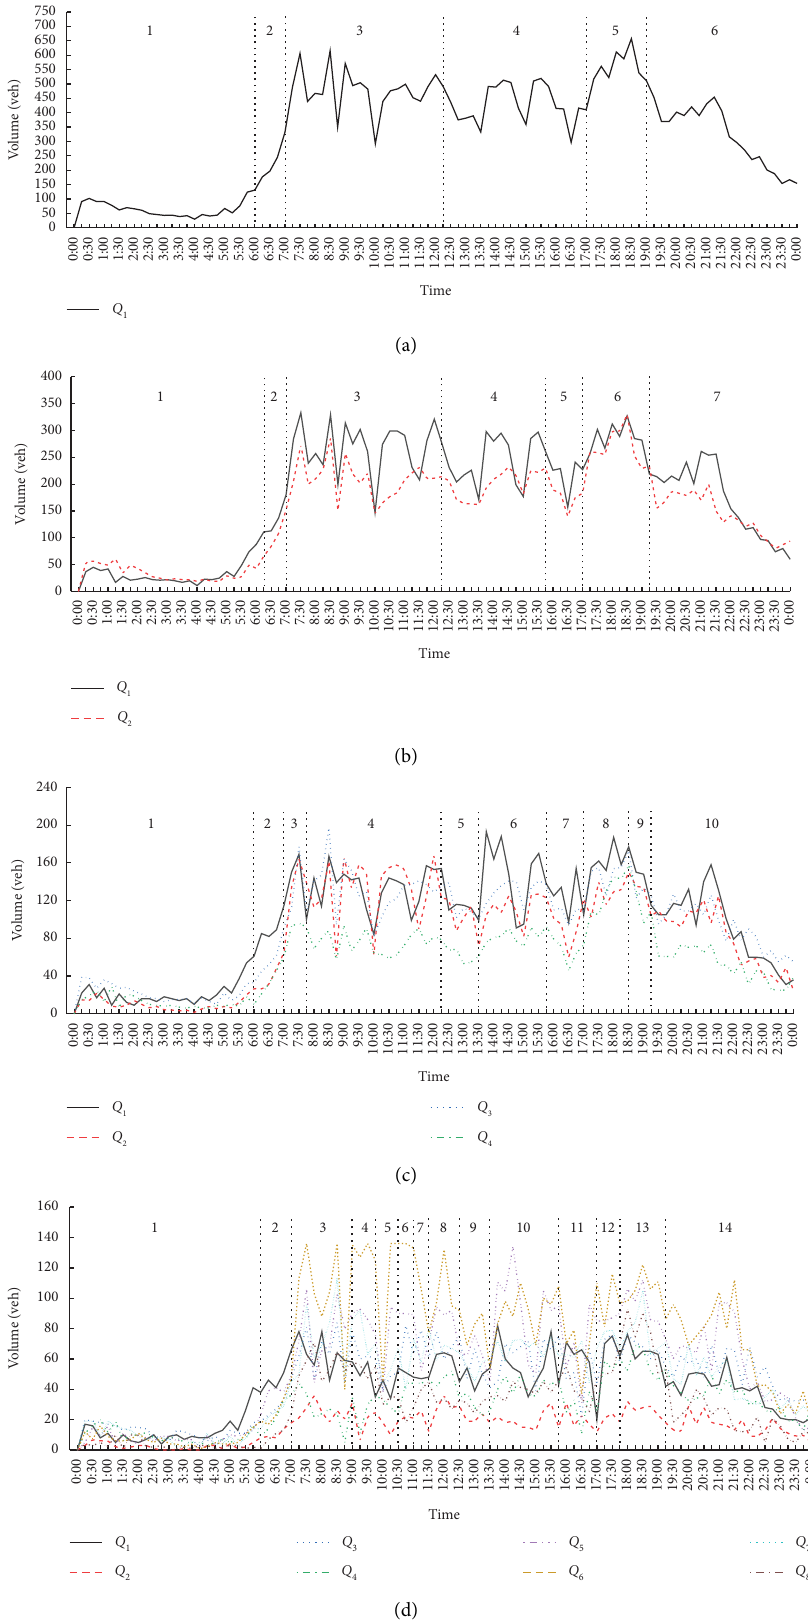
Figure 9: Final results of TOD division of Jiuhua road and Zheshan road intersection. (a) Scheme A. (b) Scheme B. (c) Scheme C. (d) Scheme D